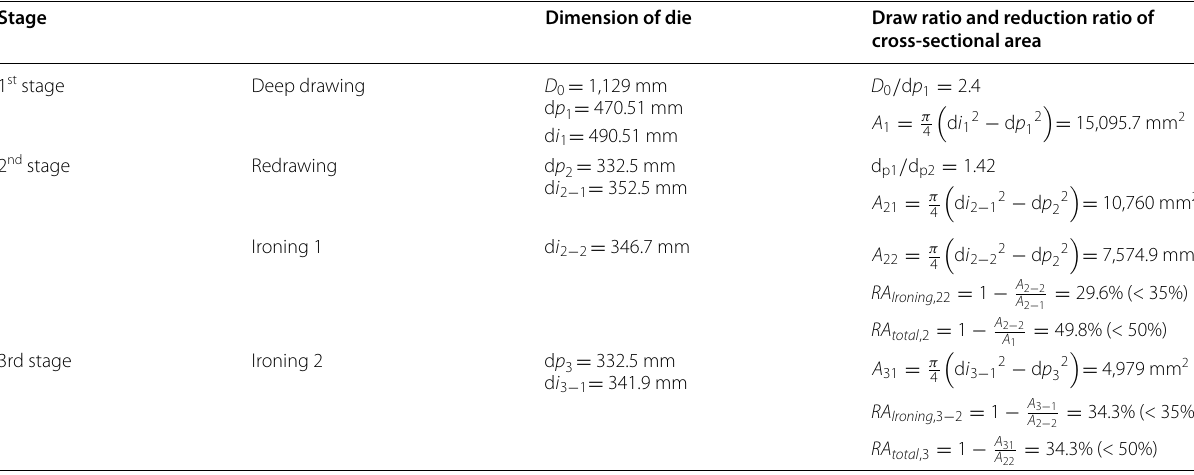
cross-sectional area